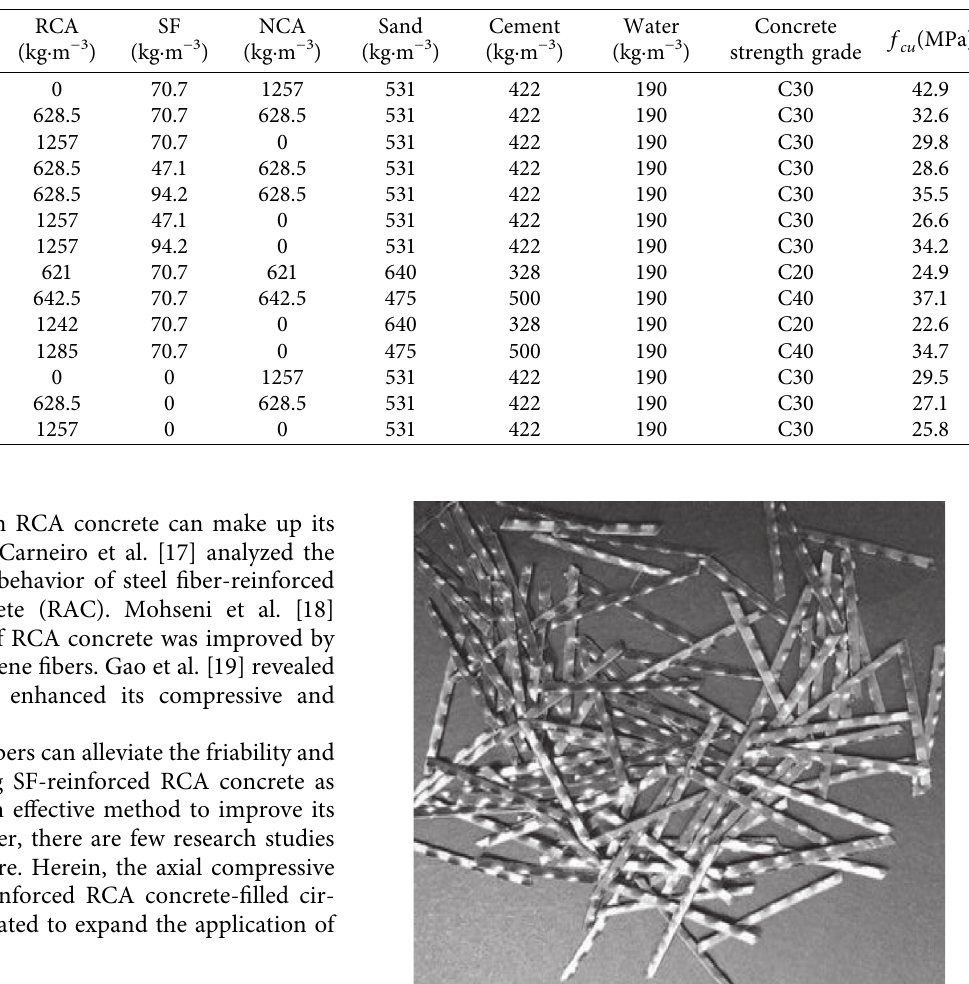
Table 1: Details of all specimens.